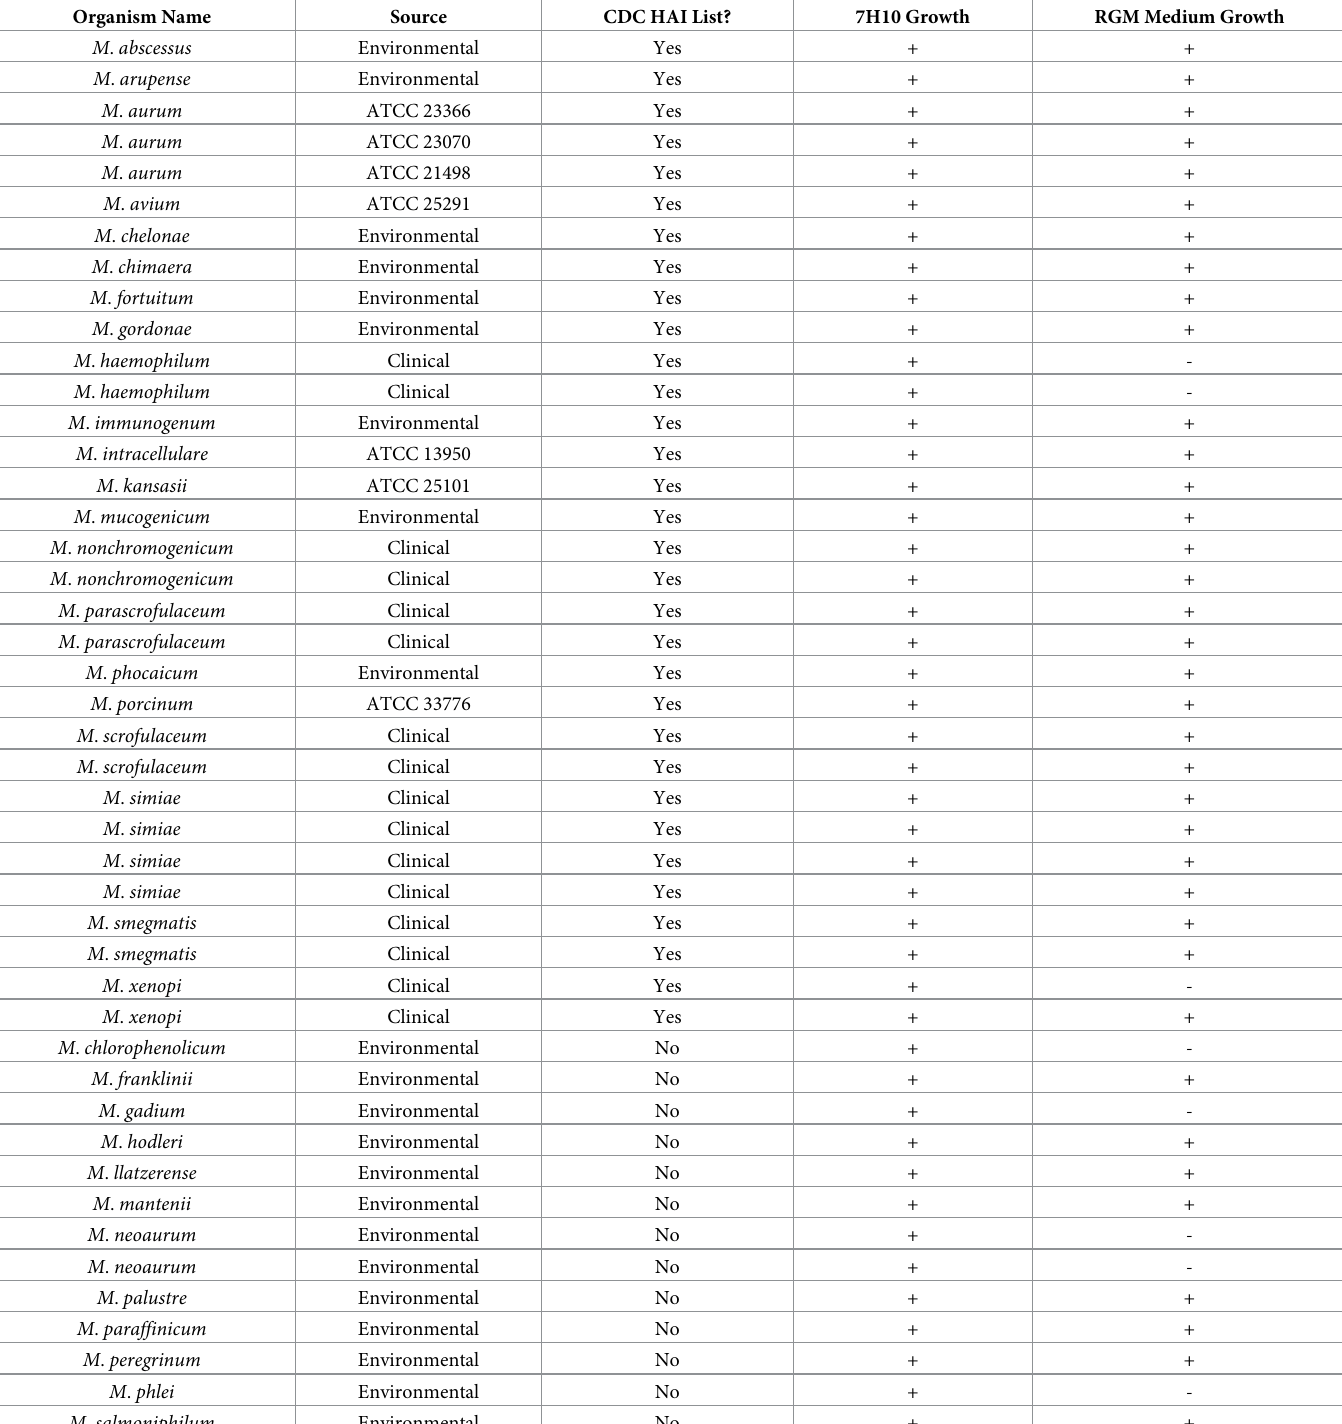
Table 4. Comparison of known NTM strains on 7H10 and RGM